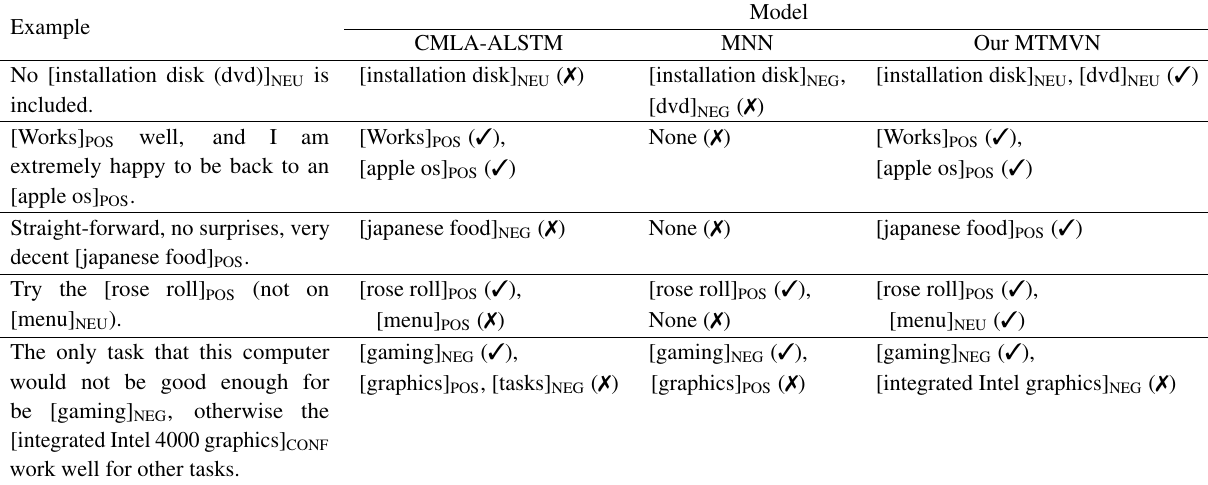
Table 6 Case analysis on CMLA ALSTM, MNN, and MTMVN; (cid:55) and (cid:51) mean wrong and correct predictions, respectively. Example CMLA-ALSTM MNN Our